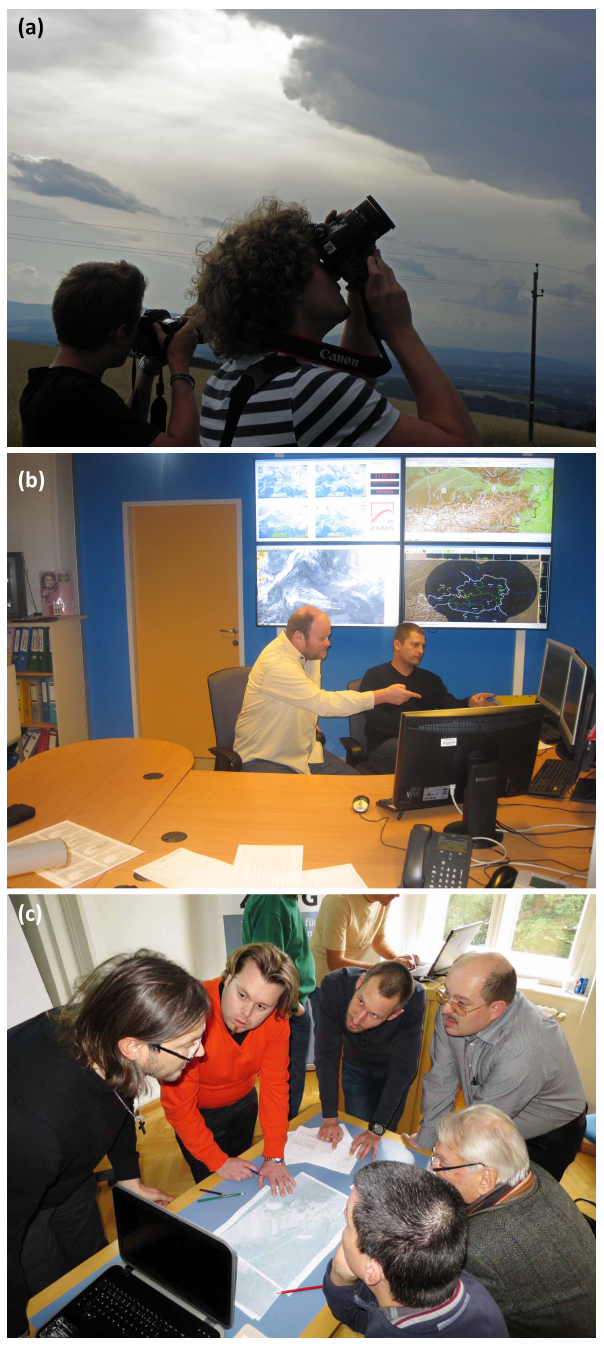
Figure 1. Storm Spotters during field observations (a) , during a job shadowing (b) , and during a practical exercise at a Trusted Spotter Network Workshop at ZAMG, Vienna (c)